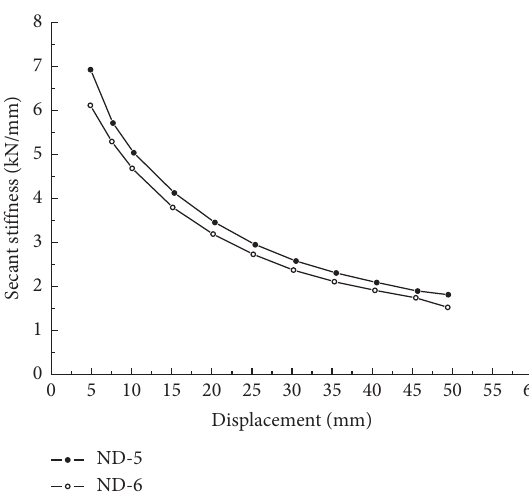
Figure 35: Stiffness curves of slit width 20mm.